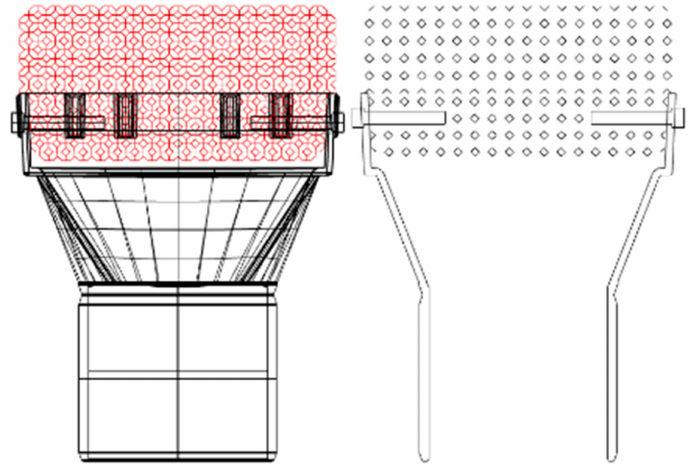
Figure 4. Sketch of the solar receiver mock-up; a SiSiC pin is used together with the Mo-wrap joining to increase mechanical